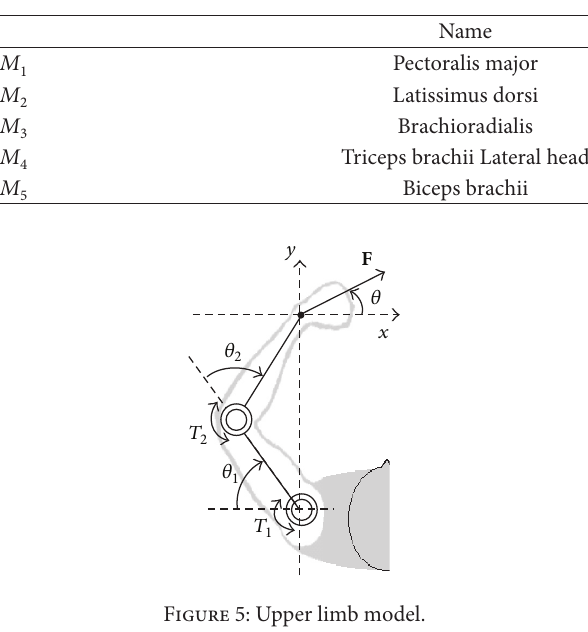
Table 1: Measured muscles.